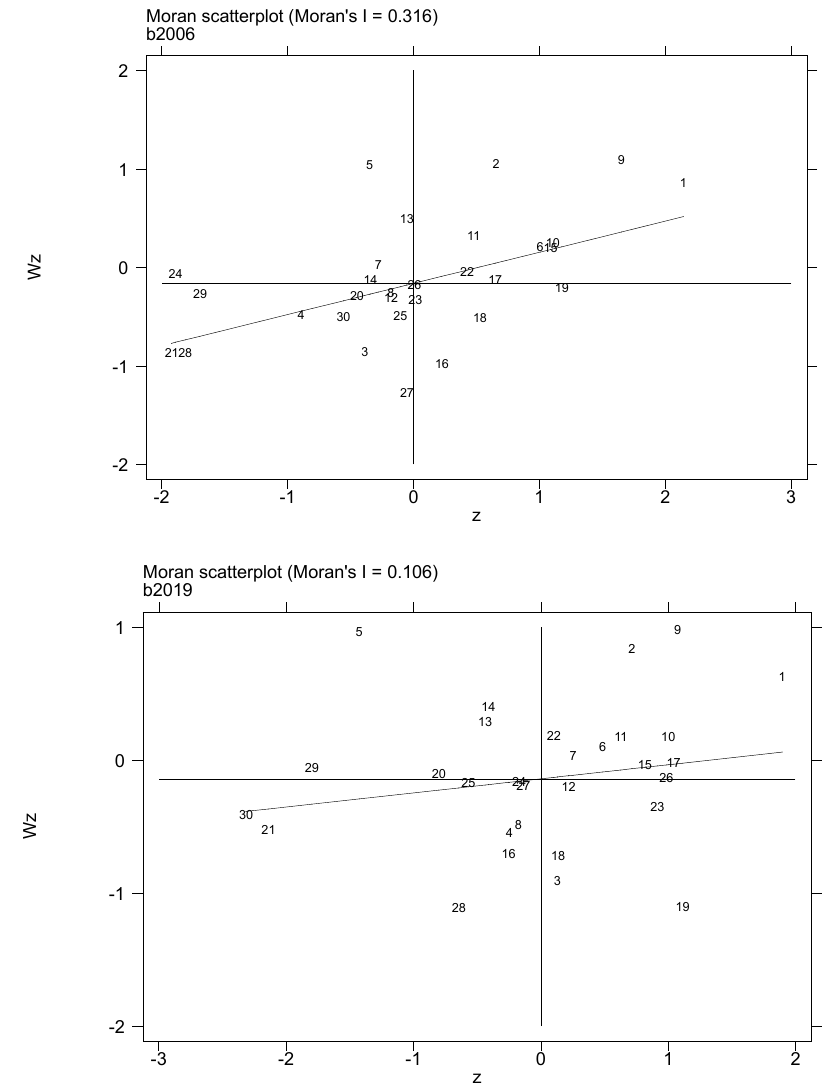
Figure 10. Moran scatter plot of agricultural technology application in 2006 and 2019.